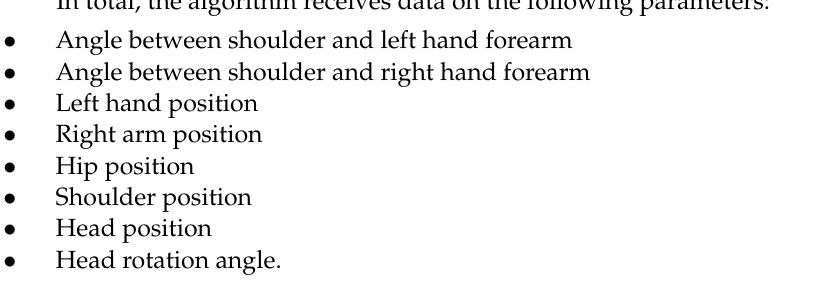
Table 4. Parameters recording methods.